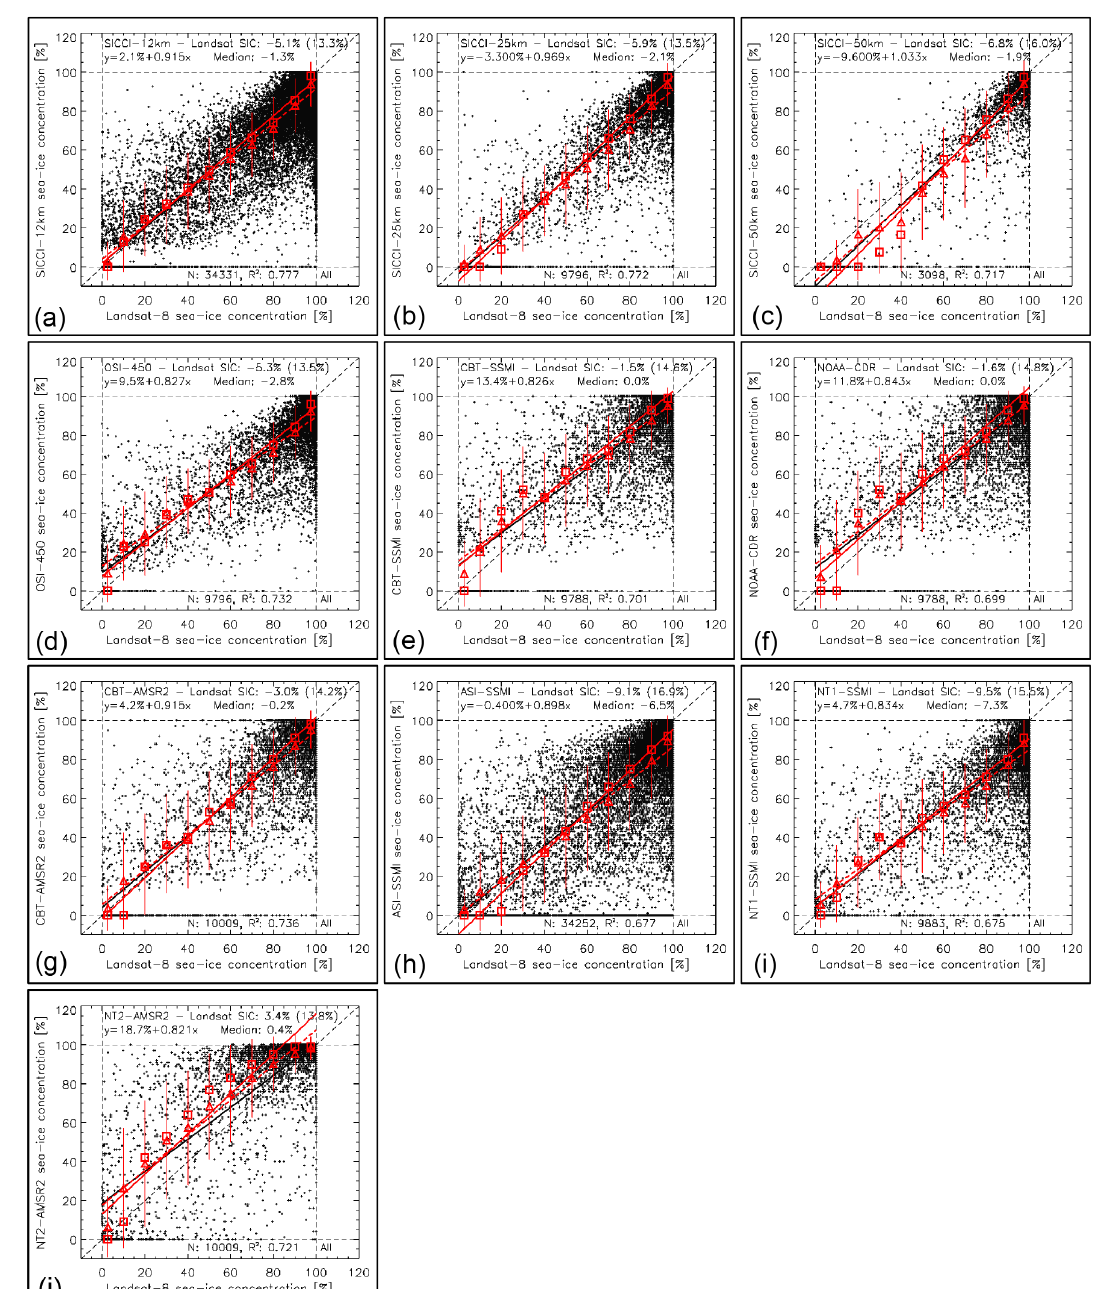
Figure 4. Scatterplots of PMW SIC ( y axis) versus Landsat SIC ( x axis) for all 10 products for 2013–2015 in the Southern Hemisphere. See Fig. 2 for a description of symbols, lines, and